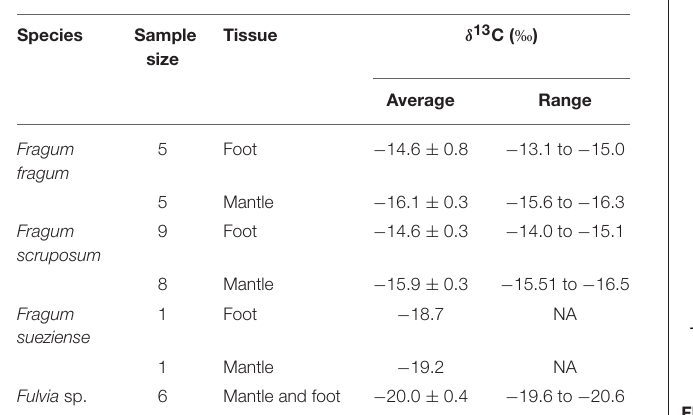
FIGURE 3 | δ 13 C values of Fraginae species, the giant clam Tridacna gigas , and the filter-feeding cardiids Cerastoderma edule and Fulvia sp. Each point represents one individual sample. Exact values are shown in Table 4 . 1 Black and Bender (1976) . 2 Rossi et al.